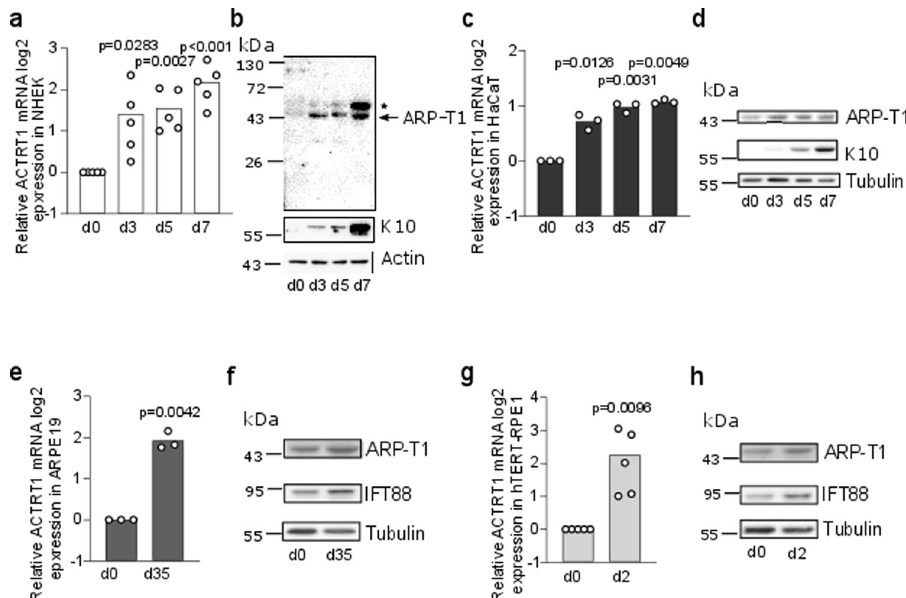
Fig. 1 ARP-T1 is expressed during epidermal and epithelial differentiation. a , c , e , g mRNA expression of ACTRT1 during differentiation of keratinocytes, NHEK ( a N = 5) and HaCaT ( c N = 3), and epithelial cells, ARPE19 ( e N = 3) and hTERT-RPE1 ( g N = 5). Data are presented as means of the fold change compared to the value of undifferentiated samples. Each open circle represents one independent experiment. b , d , f , h Representative images of ARP-T1 expression during differentiation of keratinocytes, NHEK ( b ) and HaCaT ( d ), and epithelial cells, ARPE19 ( f ) and hTERT-RPE1 ( h ). ARP-T1 was detected using guinea pig anti-ARP-T1 antisera ( b ) or mouse antibody ( d , f , h ). * indicates polymers of ARP-T1 con fi rmed by mass spectrometry analysis. Keratin 10 and IFT88 were used as markers of cell differentiation in keratinocytes and epithelial cells, respectively, actin and tubulin as loading